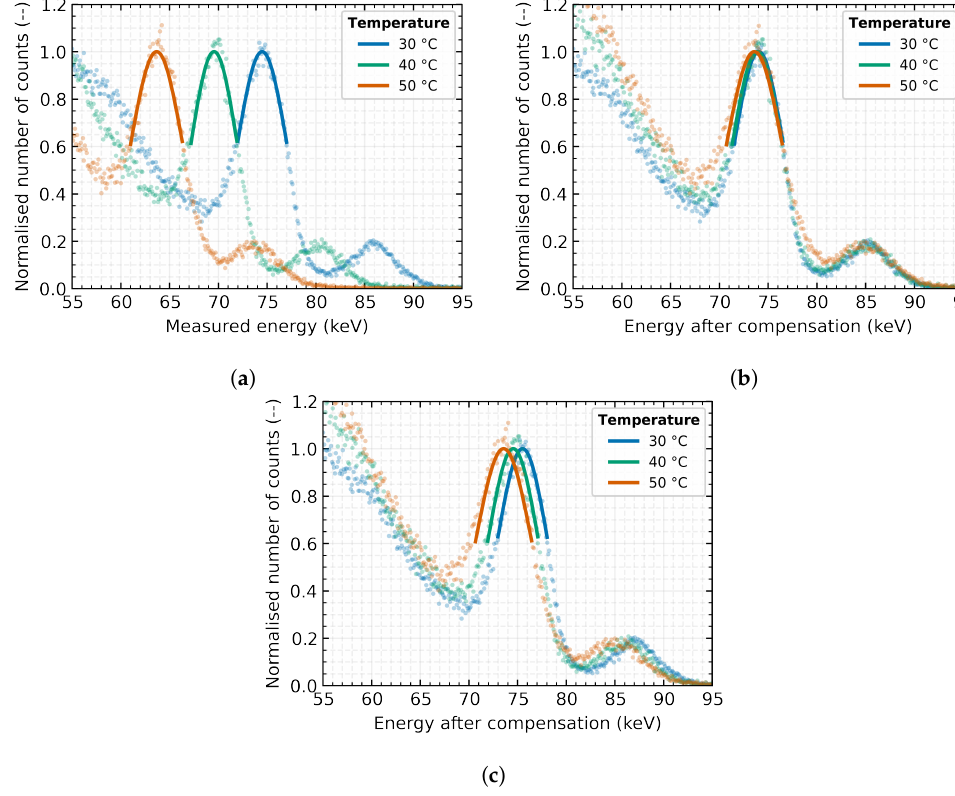
Figure 7. The comparison of the energy spectrum obtained by X-ray fluorescence with a Lead target and different compensation for thermal distortion. The measurements were performed with the detector E at three different sensor temperatures (30 ◦ C, 40 ◦ C and 50 ◦ C): ( a ) Without compensation; ( b ) Individual compensation model; ( c ) Generalised compensation model. Table 6. Comparison of the energy spectrum parameters obtained by X-ray fluorescence with a Lead target and different compensation for thermal distortion. Measurements were performed with detector E (which is outside the modelling set) at three different sensor temperatures (30 ◦ C, 40 ◦ C and 50 ◦ C). Symbol ∆ E represents the absolute measurement accuracy, RE is the relative error of measurement, and Res. is the relative energy resolution. Measured Individual Generalised